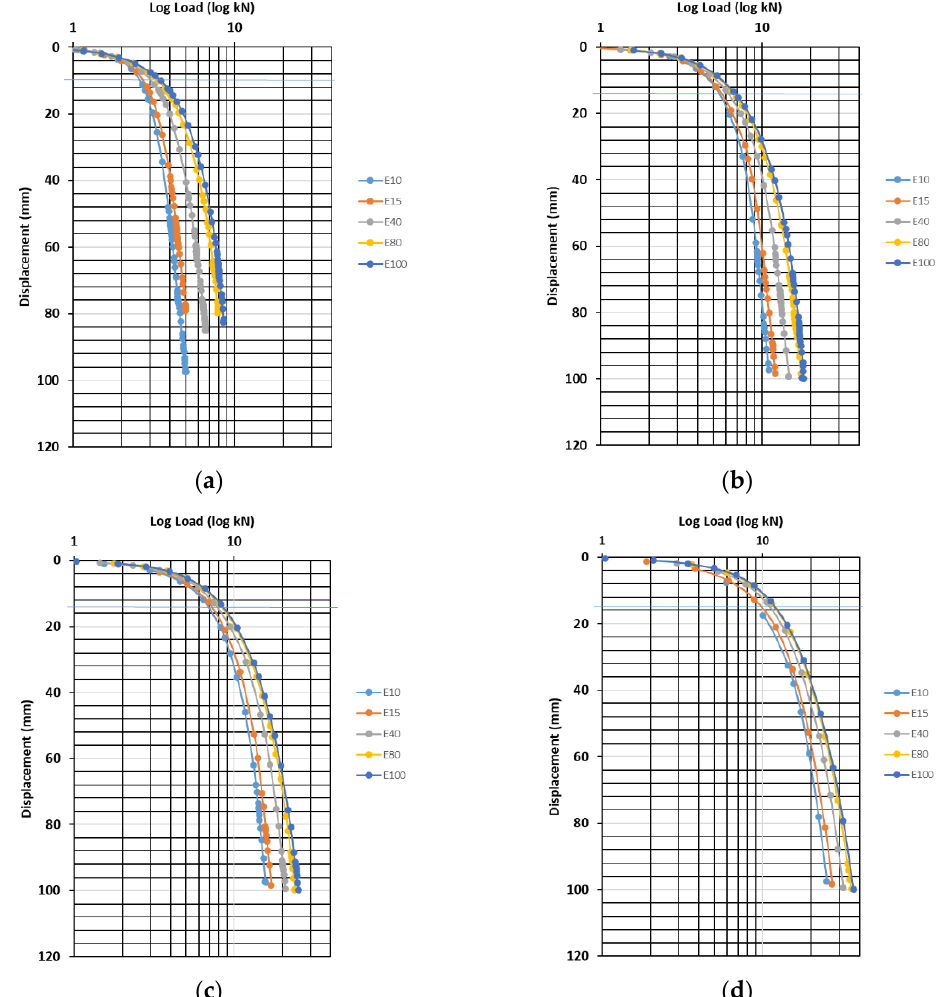
Figure 6. Load versus horizontal displacement for CHSB 1 pile. ( a ) Cohesion of 10 kPa; ( b ) cohesion of 30 kPa; ( c ) cohesion of 50 kPa; ( d ) cohesion of 100 kPa.